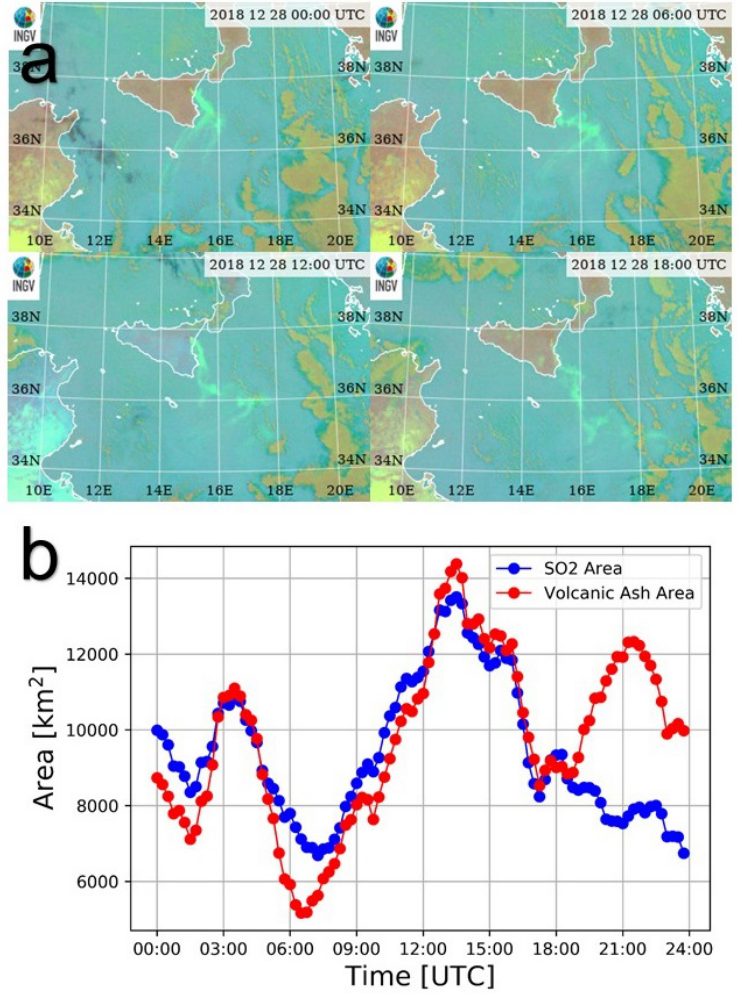
Figure 4. ( a ) Spinning Enhanced Visible and Infrared Imager composite images (red: Tb,8.7– Tb,10.8; green: Tb,12– Tb,10.8) (SEVIRI RGB) at 00:00, 06:00, 12:00 and 18:00 UTC on 28 December 2018 showing volcanic plume dispersal over Sicily; ( b ) area covered by SO 2 (blue line) and volcanic ash (red line) on 28 December 2018.